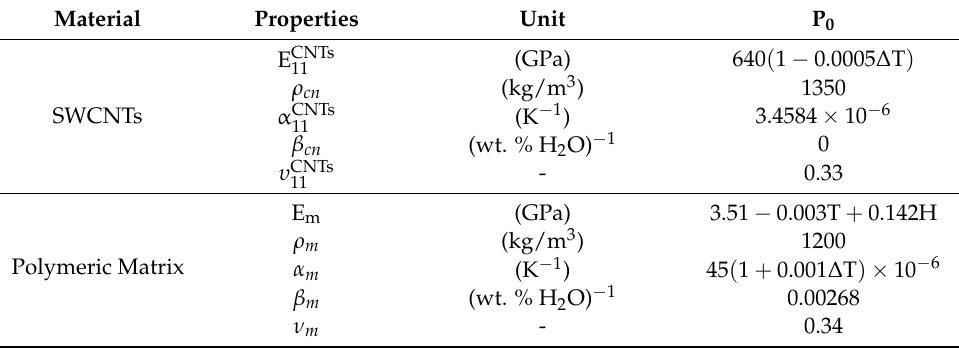
Table 1. Thermoelastic properties of SWCNTs and the polymeric matrix. Material